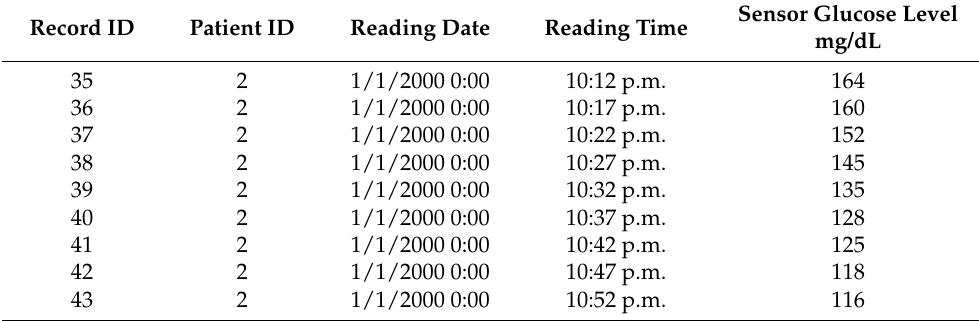
Table 1. Dataset